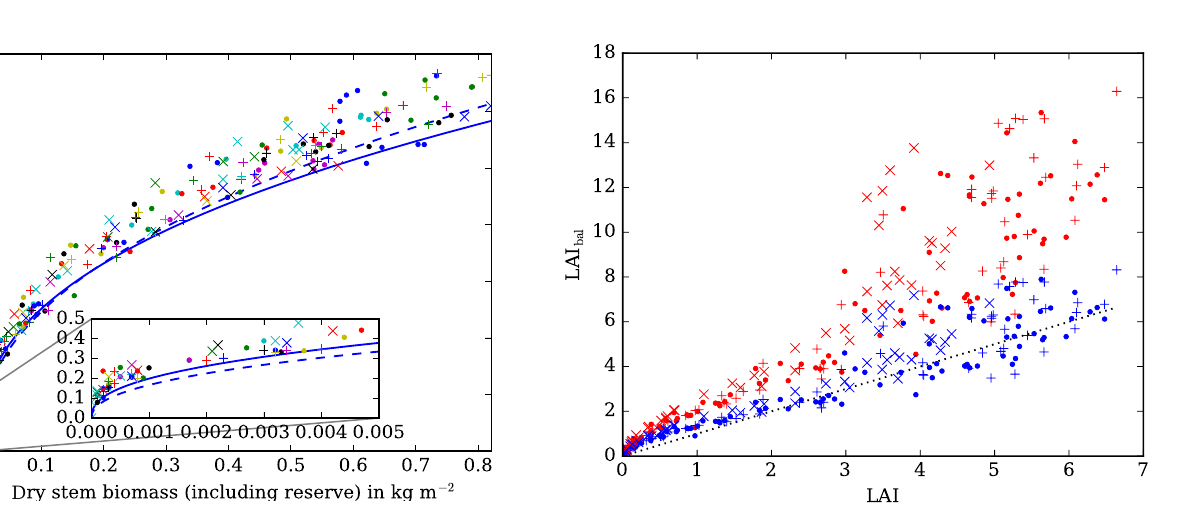
Figure 10. Stem biomass against the product of height and LAI (left) and stem biomass against the LAI (right). Dots, vertical crosses (+) and diagonal crosses (x) are US-Ne1, US-Ne2 and US-Ne3 observations respectively. Solid line shows the fit using the natural PFT parameters from Osborne et al. (2015) and dashed line shows a tuned fit using the relations for natural vegetation described in Sect. A2. Only points up until the maximum LAI measurement for that site in that year are shown.